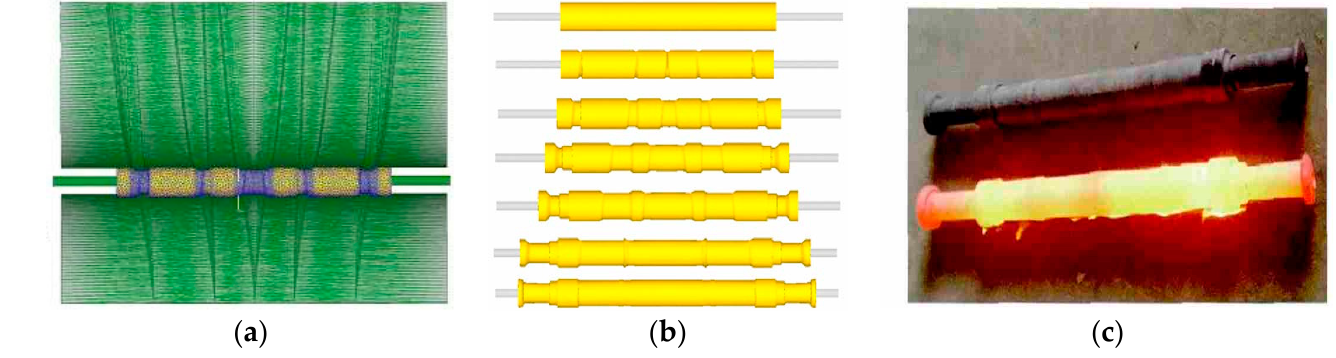
Figure 6. Hollow axle rolled with MSCWR: ( a ) FE model; ( b ) forming process; ( c ) hollow axle [5] (Reprinted with permission from Ref. [5]. 2023, Springer Nature).